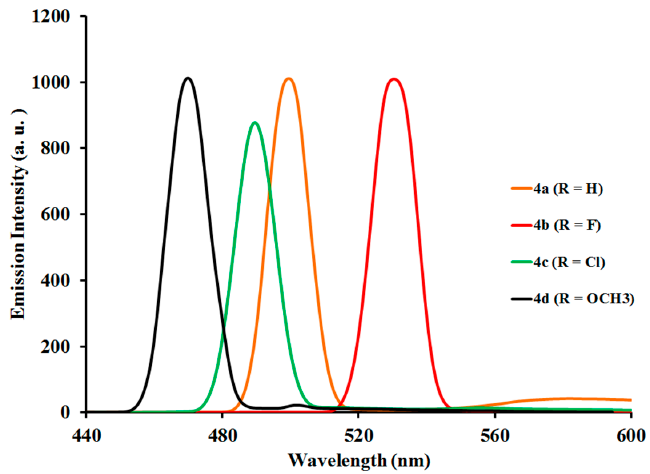
Figure 7. Phosphorescence emission spectra of (Ir ( 4a – d ) 3 ) at λ ex = 350 nm in methanol (concentration 2.0 × 10 − 7 mol/L) at RT.